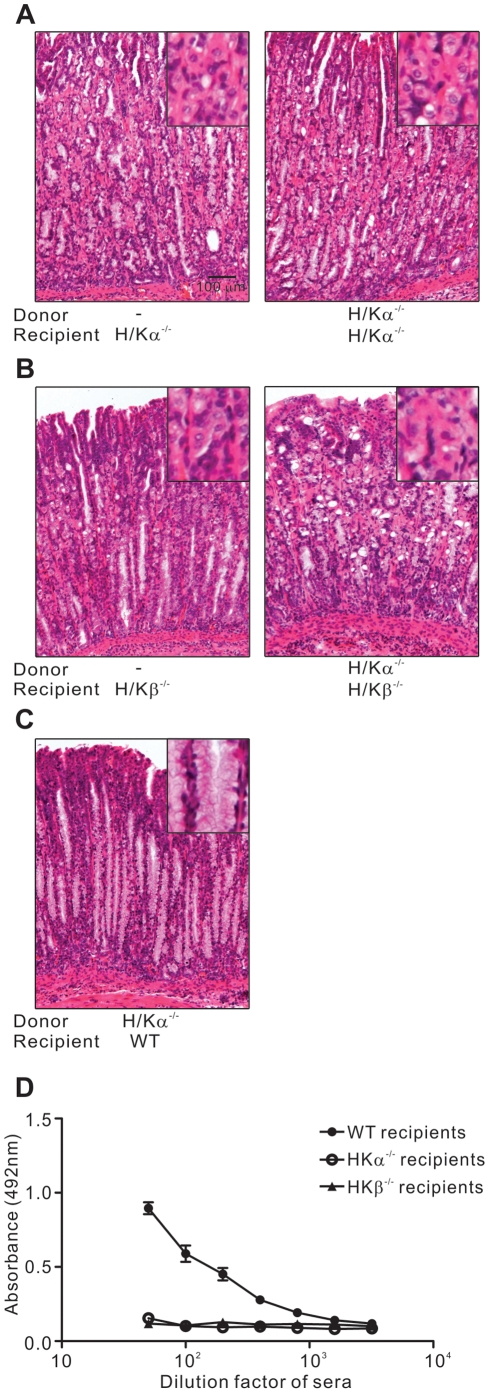
Autoimmune gastritis does not develop in the absence of gastric H/Kα or H/Kβ.Gastric pathology in (A) H/Kα−/− mice received either H/Kα−/− CD4+ T cells or no inoculum (−) (B) H/Kβ−/− mice received either H/Kα−/− CD4+ T cells or no inoculum (−) (C) WT mice received H/Kα−/− CD4+ T cells. Images representative of results of at least 9 mice in each group are shown. (D) Serum samples were collected from H/Kα−/−, H/Kβ−/− or WT mice that received CD4+ T cells from H/Kα−/− mice. H+/K+ ATPase-specific autoantibodies in serum were detected by ELISA using serial 2-fold dilutions of mouse sera, with a starting dilution factor of 50. Data pooled from four independent experiments. Error bars, standard error.